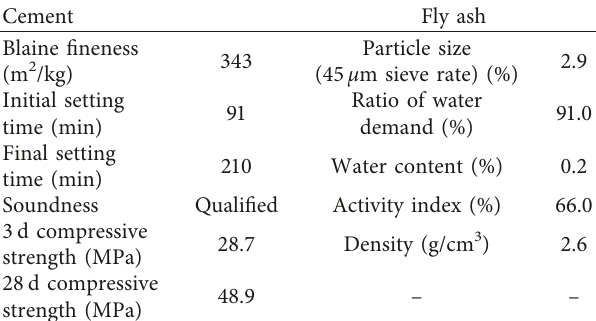
Table 1: The physical properties of cement and fly